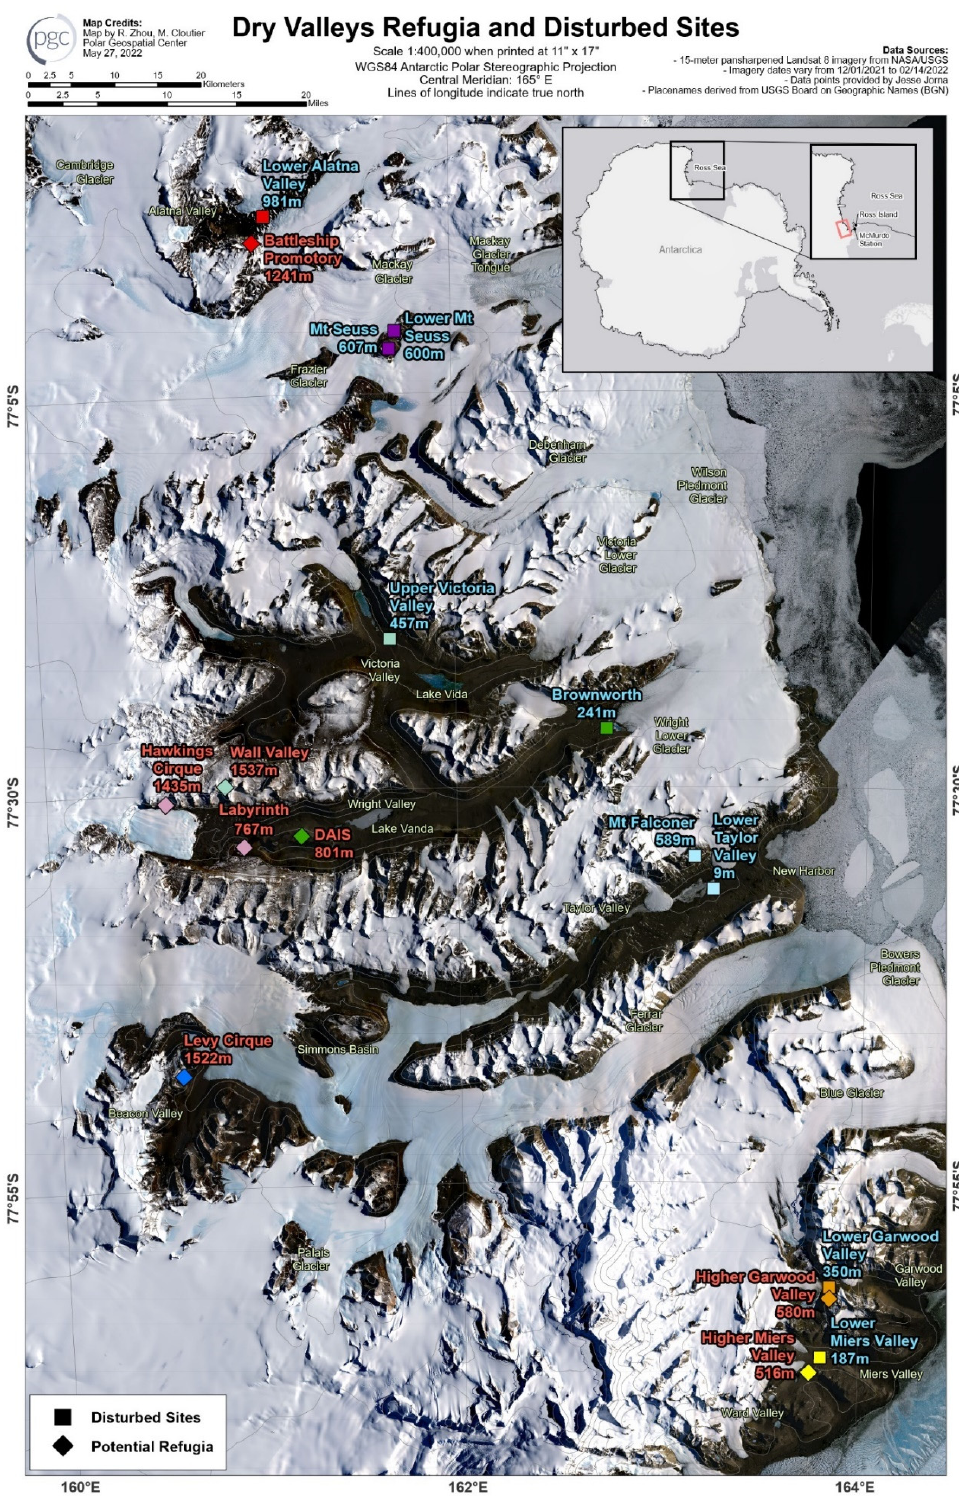
Figure 1. Map of the McMurdo Dry Valleys (MDV) and sampling sites. All 17 samples are displayed at their approximate location of origin. Sites that are classified as disturbed sites are displayed as a square symbol and are marked with blue text, and putative refugia are displayed as diamonds and accompanying red text. Colors of the site markers indicate which valley basin samples came